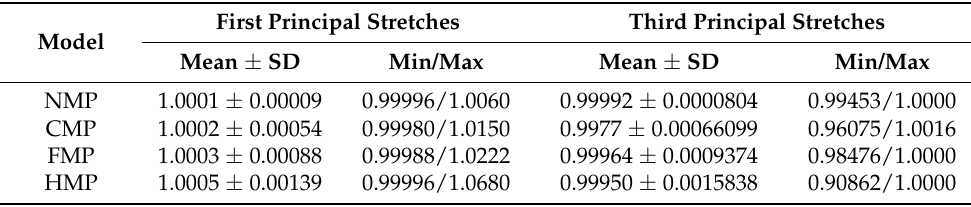
Table 10. Mean and range of stretches over the soft